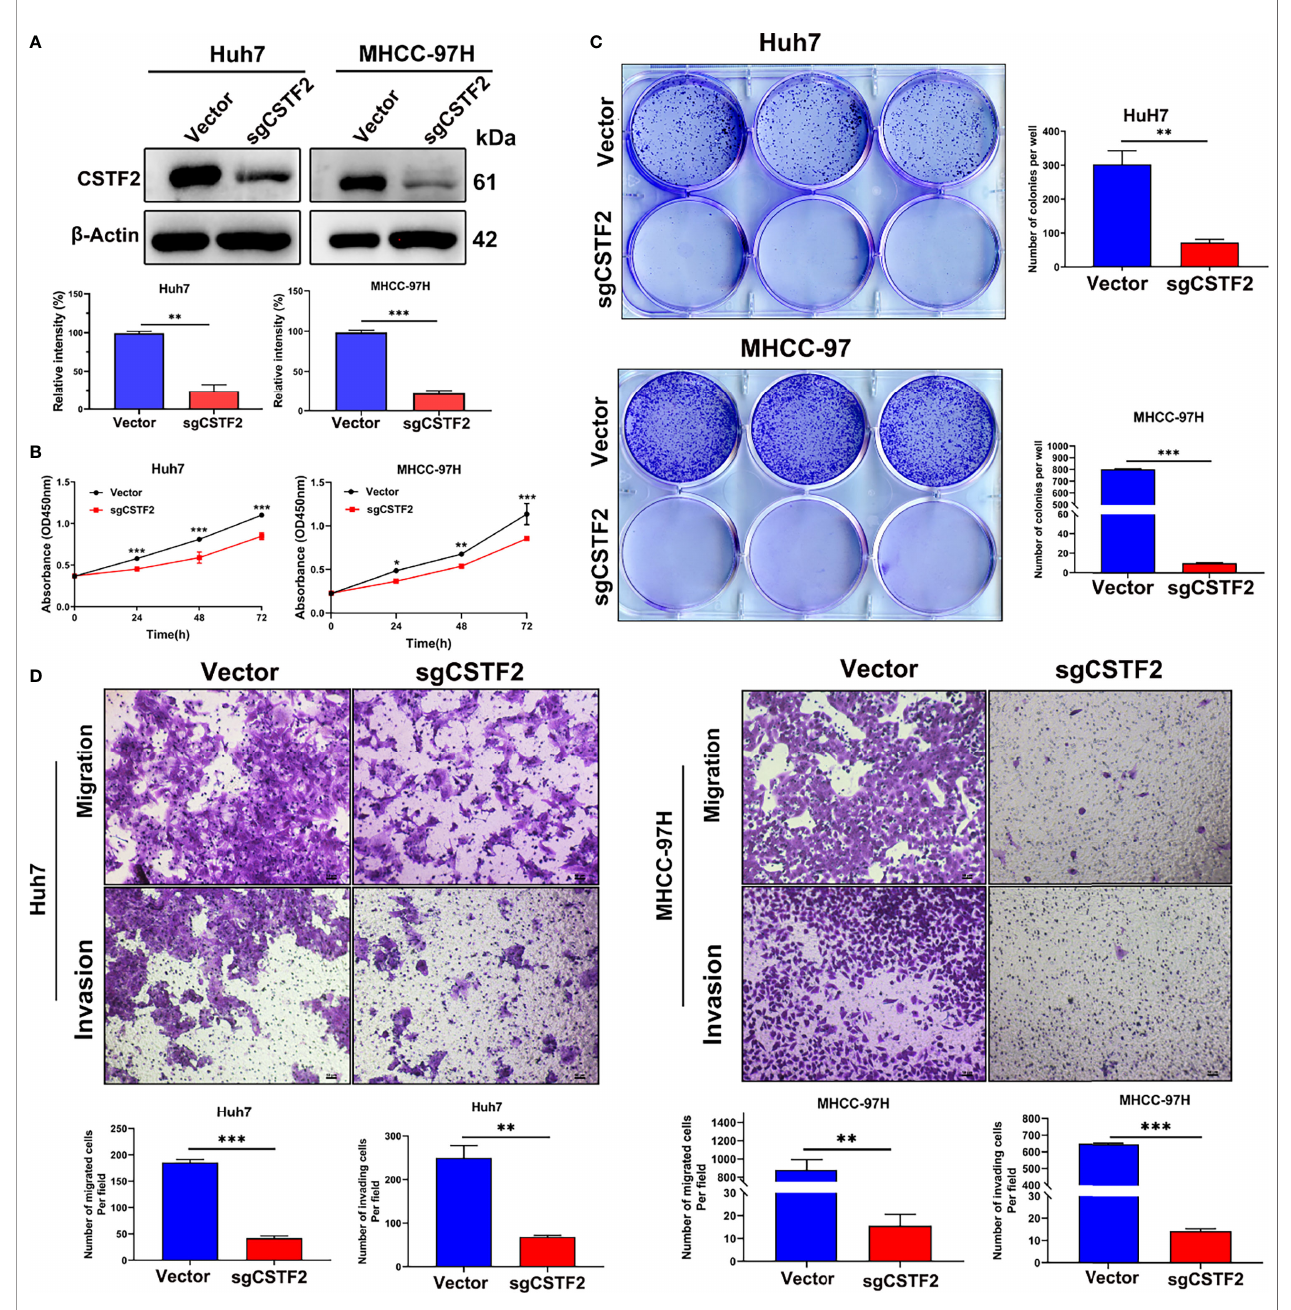
FIGURE 5 | Knockout of CSTF2 inhibited the proliferation, migration, and invasion of HCC cells in vitro . (A) The stable CSTF2 knockout Huh7 and MHCC-97H cells were determined by Western blot (upper panel) and the quali fi cation of the relative intensity of CSTF2 protein levels (bottom panel). The levels of b -actin were used as an internal control. (B) The cell proliferation ability of CSTF2 knockout Huh7 and MHCC-97H cells was measured by the CCK-8 assay. (C) Colony-forming assay of CSTF2 knockout Huh7 cells and MHCC-97H cells (left panel) and the quali fi cation of the number of colonies in these cells (right panel). (D) The migration and invasion capacity were evaluated in CSTF2 knockout Huh7 cells and MHCC-97H cells by the Transwell assay (upper panel) and the quali fi cation of migrated cells and invading cells per fi eld (bottom panel). Scale bar, 50 m m. sgCSTF2 represents CSTF2-sgRNA. An empty vector was used as a control of CSTF2-sgRNA. * r < 0.05, ** p < 0.01, *** p < 0.001 compared to vector